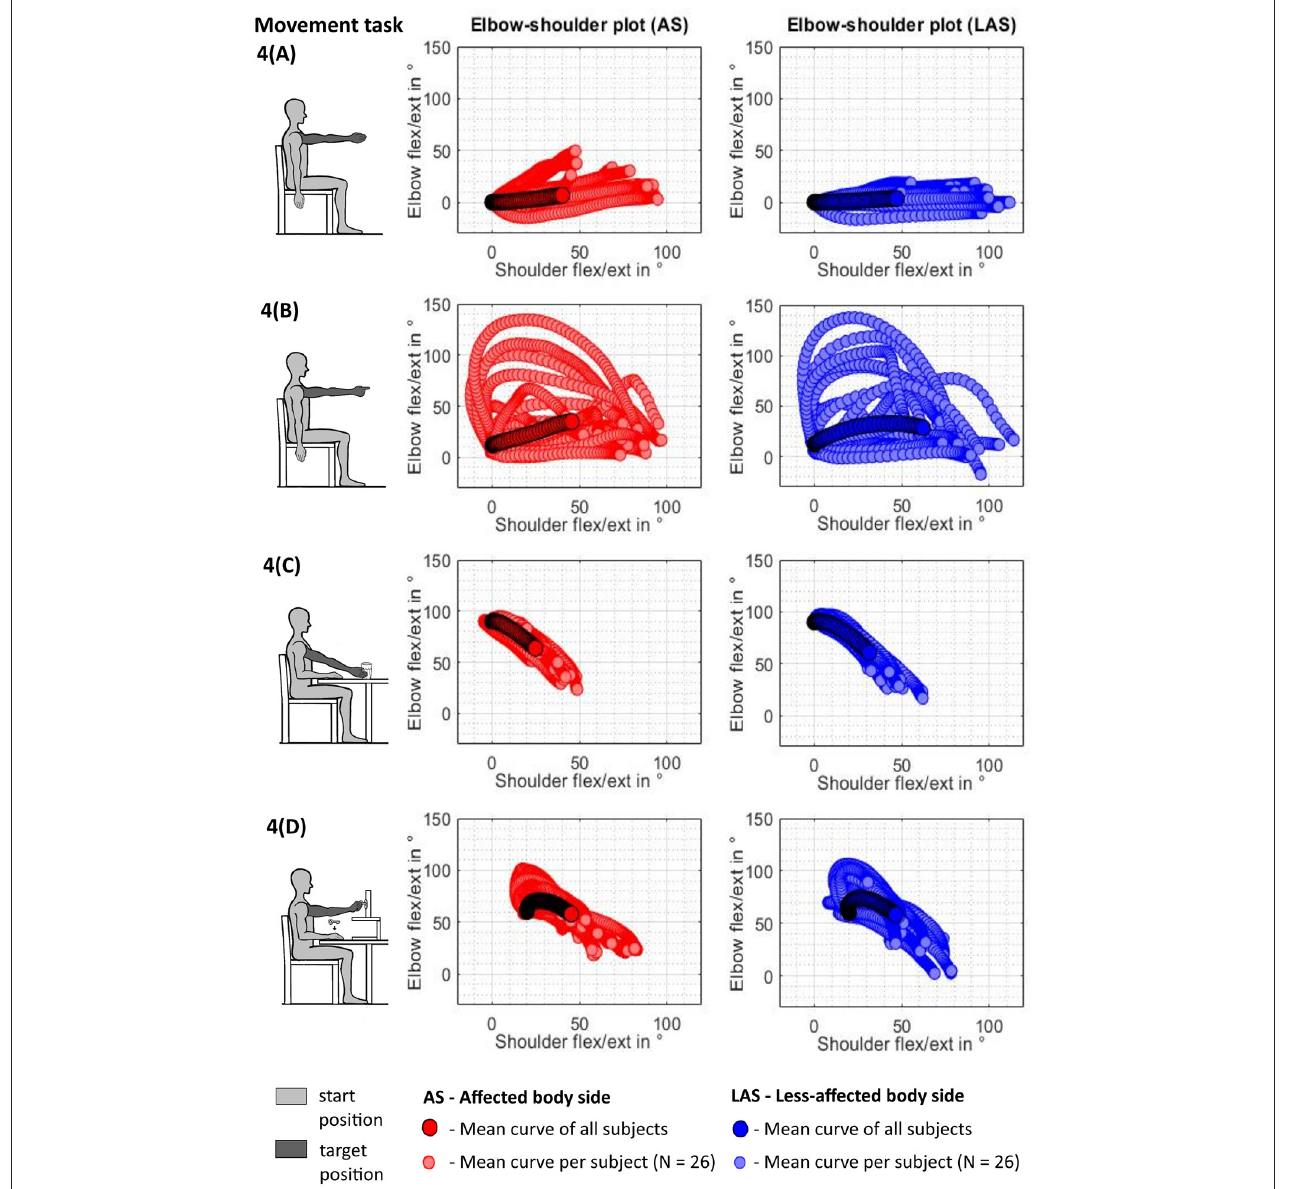
FIGURE 5 | Shoulder–elbow mean curve per tested arm and task across subjects ( N = 26). (A) Shoulder flexion. (B) Pointing ahead. (C) reach-to-grasp a glass. (D) Key